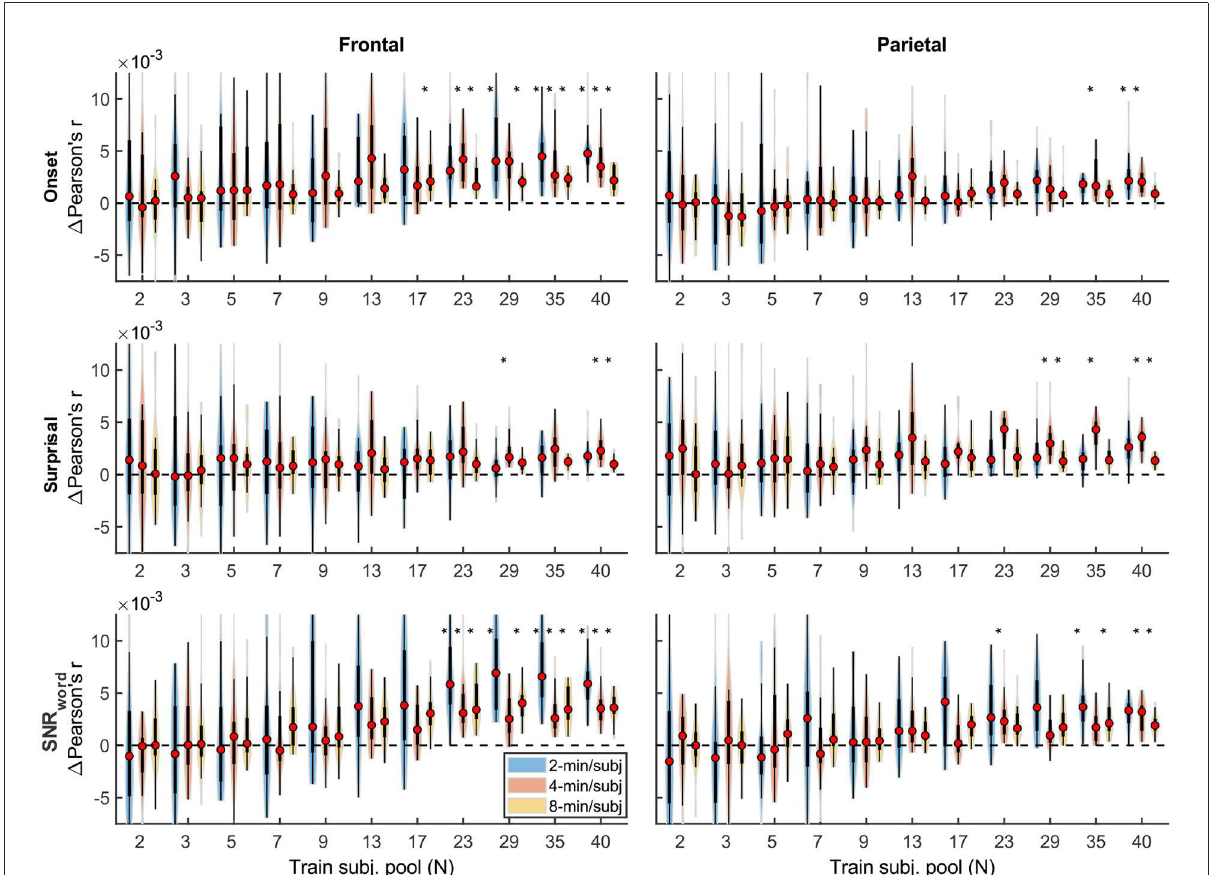
FIGURE11 Feature-specific generic model contributions as a function of training subject pool size, for the sparser model, with 2-, 4-, and 8-min of training data per subject (violin color; see legend in the lower left plot). Asterisks denote significance levels as in Figure